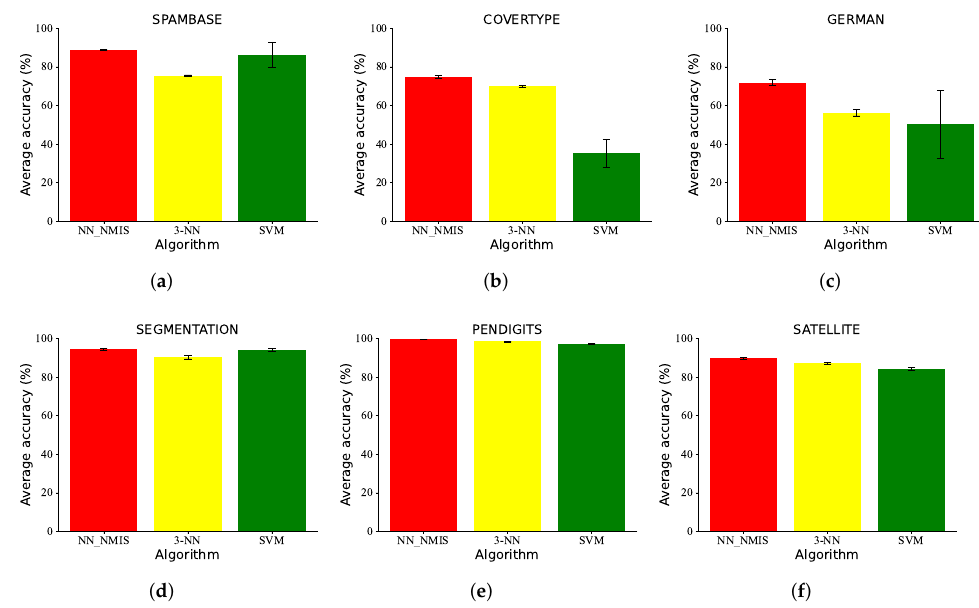
Figure 9. The large-scale data classification results (%) of NN_NMIS, KNN and SVM on ( a ) SPAM- BASE, ( b ) COVERTYPE, ( c ) GERMAN, ( d ) SEGMENTATION, ( e ) PENDIGITS and ( f ) SATEL- LITE